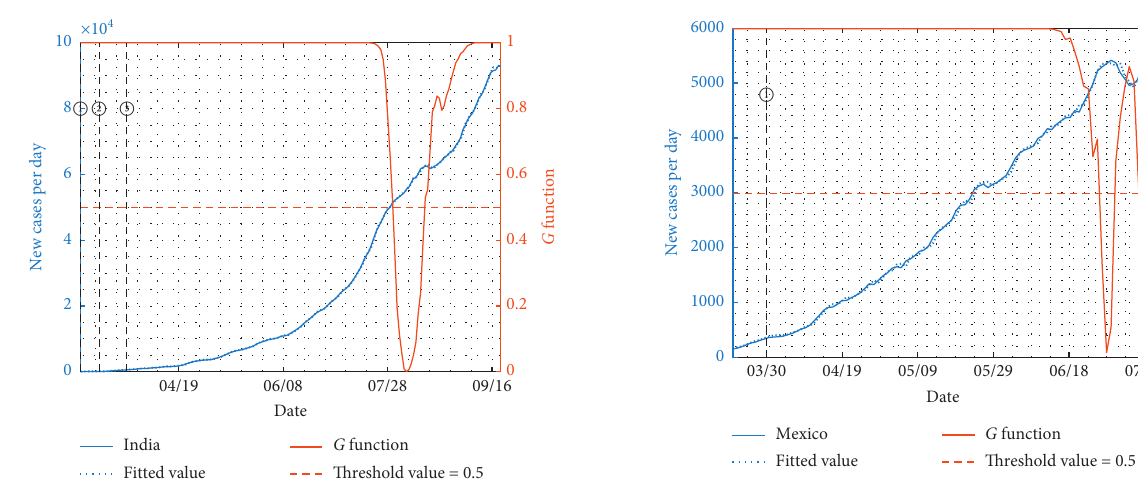
Figure 15: The fitting result of India. The left axis shows the daily confirmed cases for the real data after smoothness (blue solid line) and its fitted values by the STAR model (blue dashed line). The right axis shows the value of nonlinear functions G changing with time (orange solid line) and the reference line with threshold 0.5 (orange dashed line). The vertical dotted line indicates the se- quential released policies: ① ban travellers from Italy, Iran, Korea, and Japan, ② suspend visas of tourists, and ③ implement a lockdown policy.